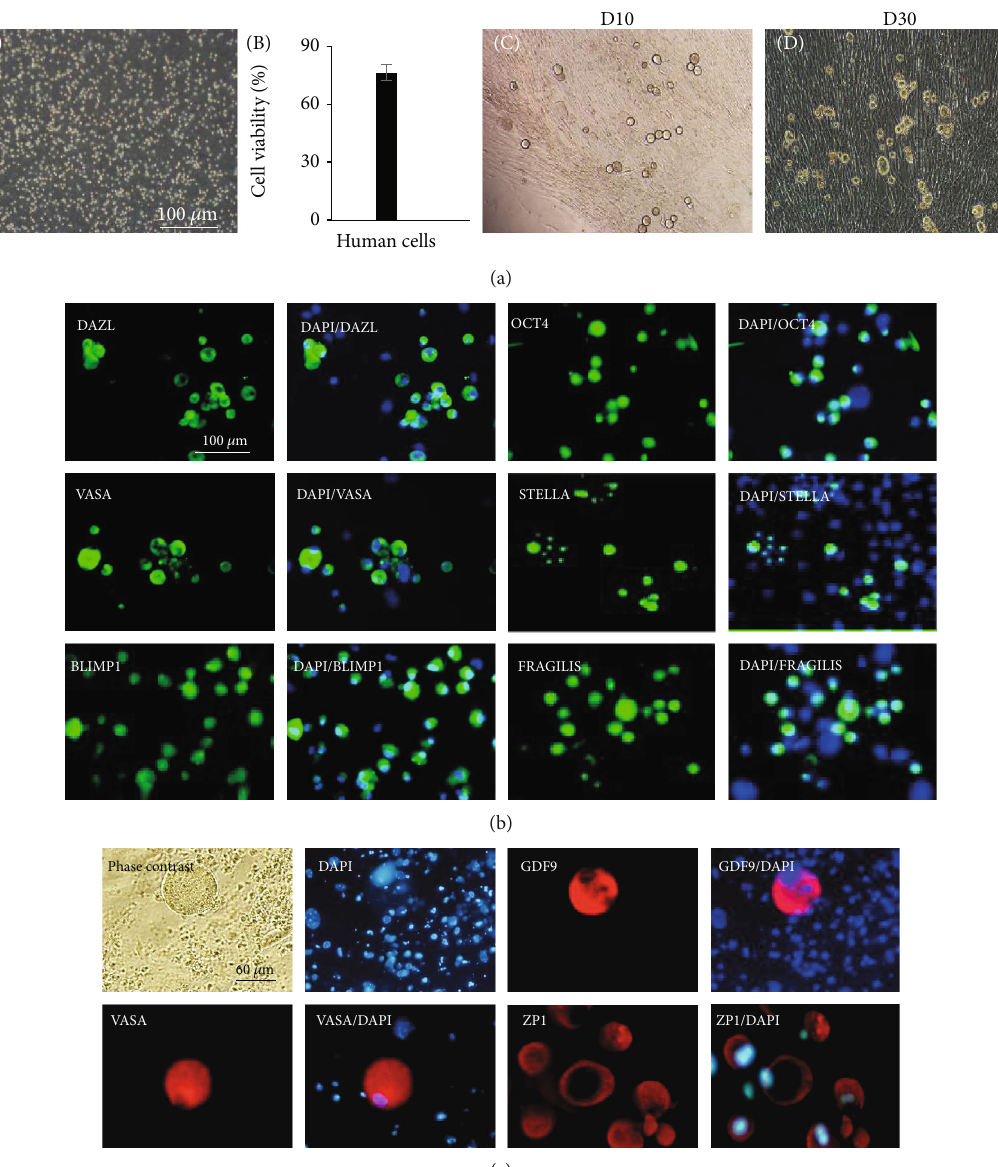
Figure 4: Characteristics of human female germline stem cells. (a) Phase contrast images of human ovarian cells after the isolation (A) and culture on di ff erent days (C and D); viability percentage of human ovarian cells after the isolation by using PI staining analyzed by BD FACS Aria II. (b) Immuno fl uorescence staining for germline markers in fGSCs on day 20 of culture in MEF-coated plates. (c) OLCs formed spontaneously from the fGSCs in the culture. Phase contrast and immuno fl uorescence staining images for oocyte markers (GDF9, ZP1, and VAZA) of di ff erentiated OLCs in the